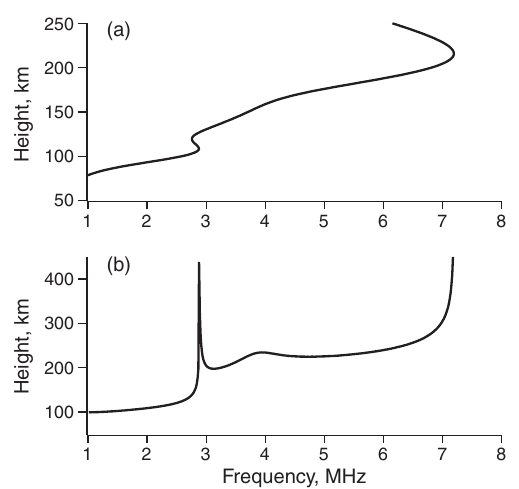
Figure 4. Electron density profile of the unperturbed ionosphere (a) and synthesized ionogram assuming vertical incidence of sounding radio waves (b)